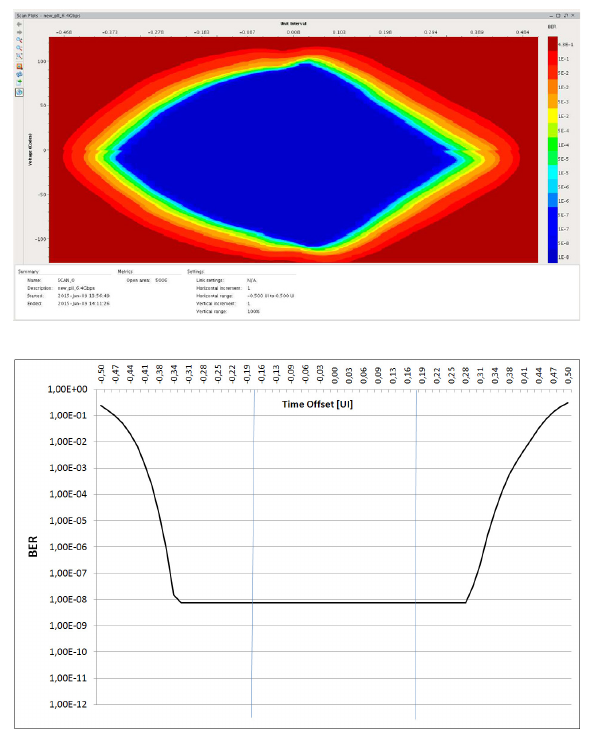
Figure 2. Block diagram of the FPGA firmware for the test of the ALICE new tracker modules